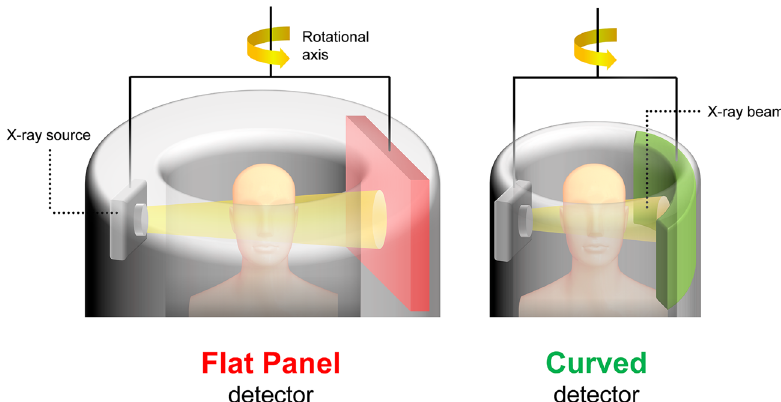
Fig. 1 Curved vs. planar fl at panel digital X-ray detector in medical cone beam computed tomography (CBCT). CBCT is a technology that creates three-dimensional views of objects based on a series of two-dimensional X-ray images. Today ’ s CBCT systems are typically very large as they have a 2D fl at panel digital X-ray detector mounted on a gantry that rotates around the subject being examined to capture the data required for a 3D image reconstruction. Here, curving the detector would mean its edges describe a smaller circle as the gantry rotates, so the whole system could be more compact. See Supplementary Information for more details. A planar X-ray source is shown instead of a bulky X- ray source for the sake of simplicity.